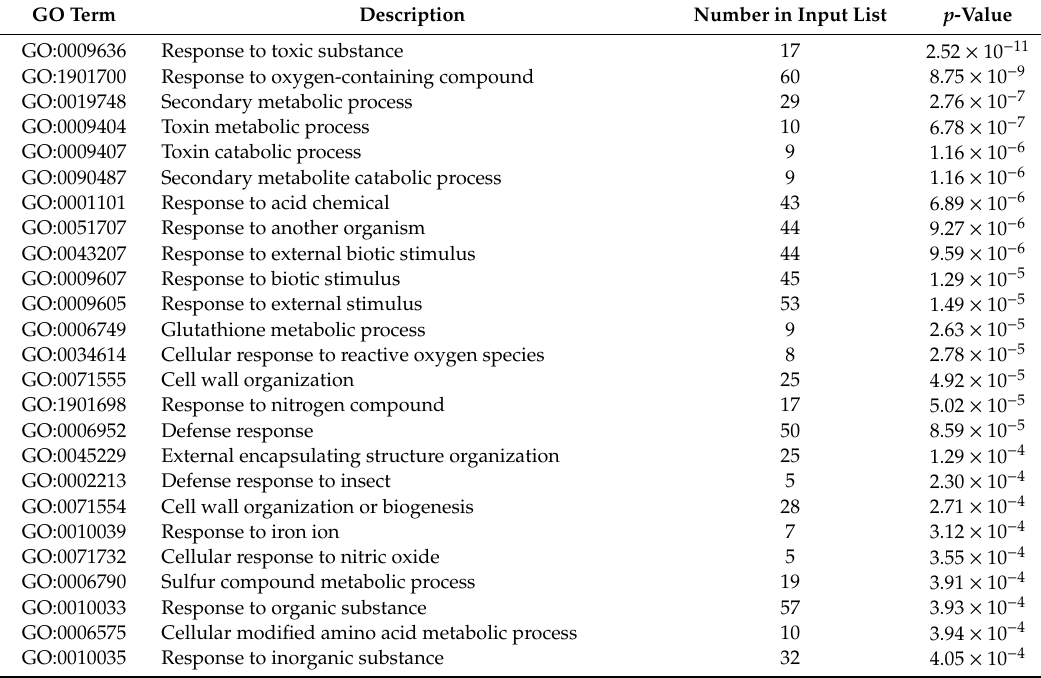
Table 2. List of GO terms of genes upregulated more than 2-fold in HRE1 β